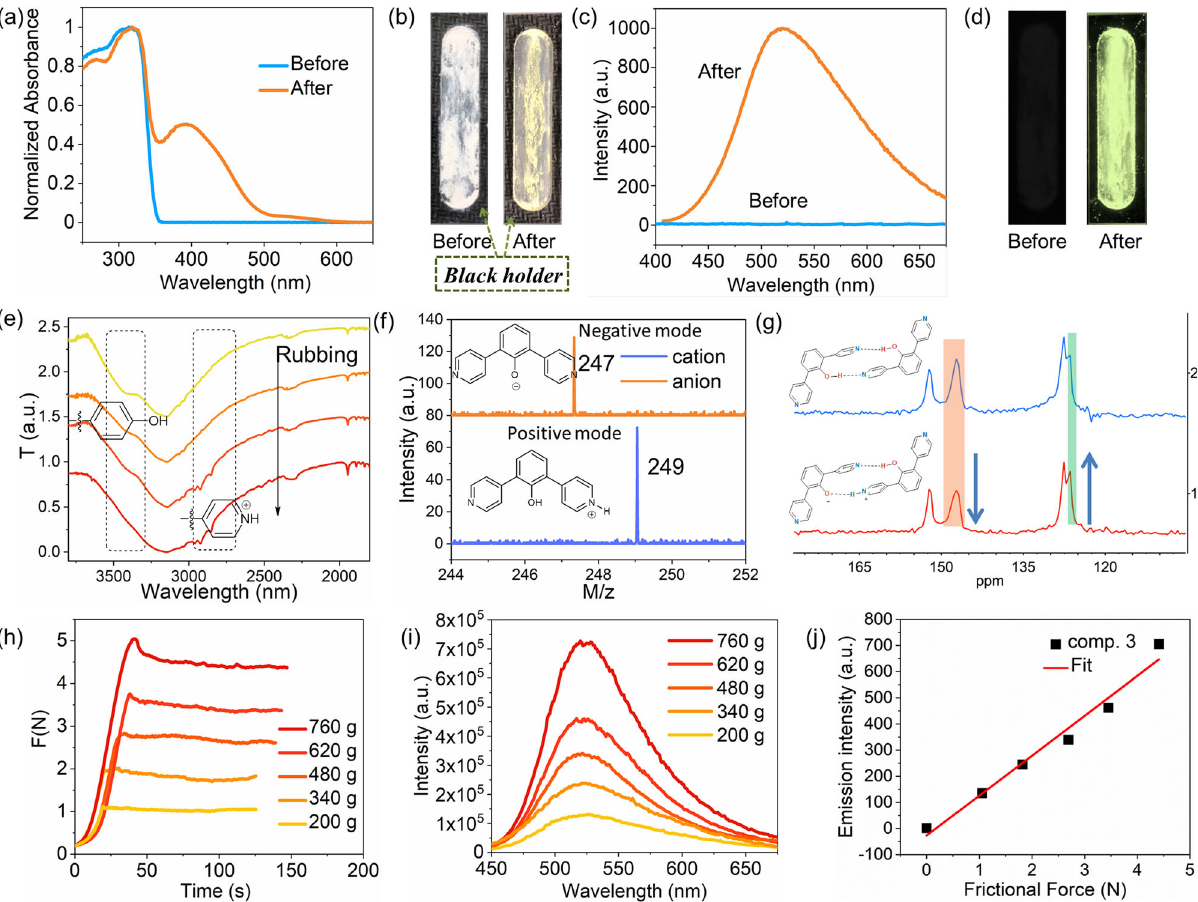
Fig. 2 Rubbing luminescence. a Absorption spectra and ( b ) the corresponding photograph under daylight of 3 in the solid state before and after rubbing; c emission spectra and ( d ) the corresponding photograph under UV light of 3 in the solid state before and after rubbing. e FTIR spectra of 3 upon a continuous rubbing process. f MALDI-TOF results of 3 after rubbing; g partially magni fi ed solid state 13 C NMR spectra of compound 3 before (blue) and after rubbing (red). h Friction diagram between the rubber and glass substrate of the solid sample of 3 under different loads. i Friction force-dependent emission spectra of 3. j Plots of the emission intensity vs. the friction force.